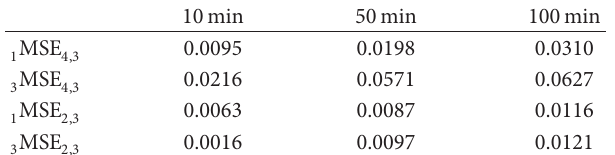
T 3: Mean square error between the curves of the reliability applied to real and synthetic data.